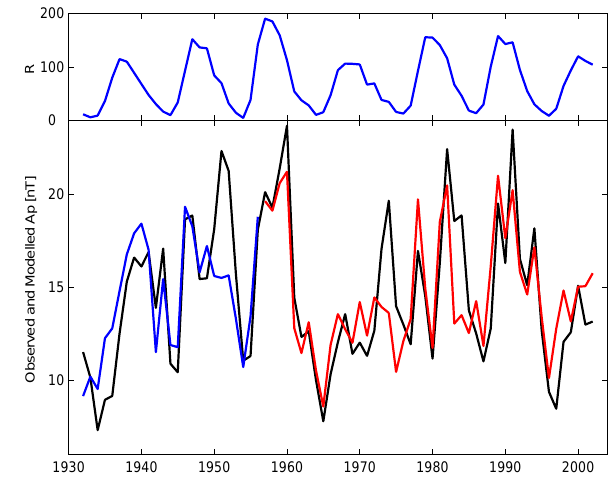
Fig. 7. Top: annual sunspot numbers. Bottom: annually averaged A p indices (black) and A p calculated from the best fitting correla- tion with the reconstructed D st index in 1932–1956 (blue) and in 1957–2002